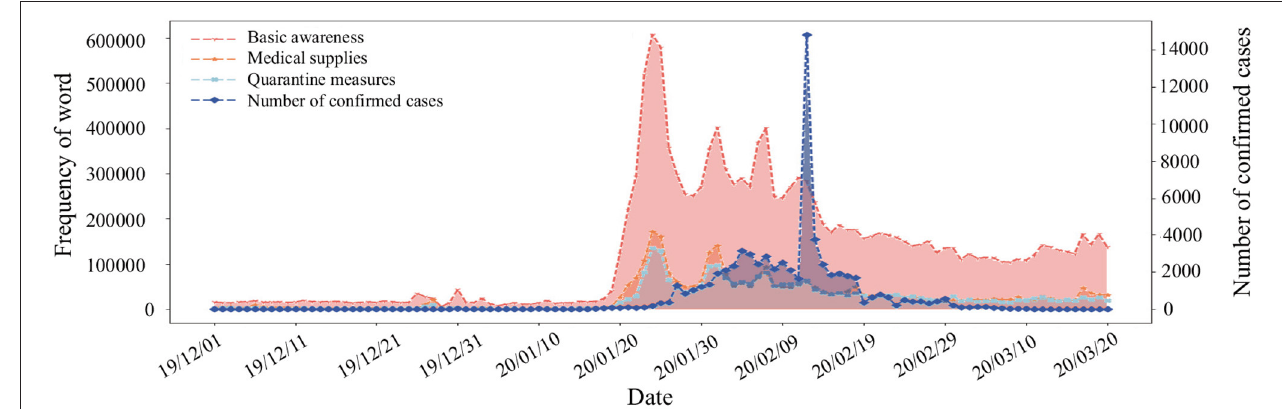
FIGURE 1 | Trend of confirmed cases and frequency of the epidemic-related